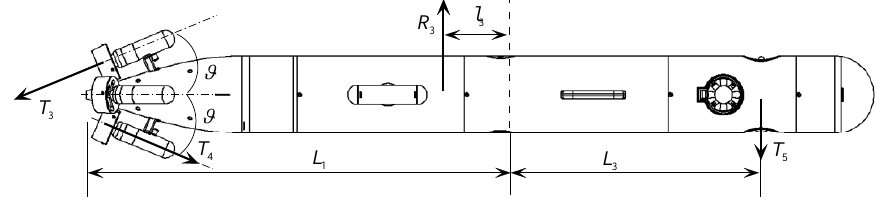
Figure 6. Force analysis when moving lateral.